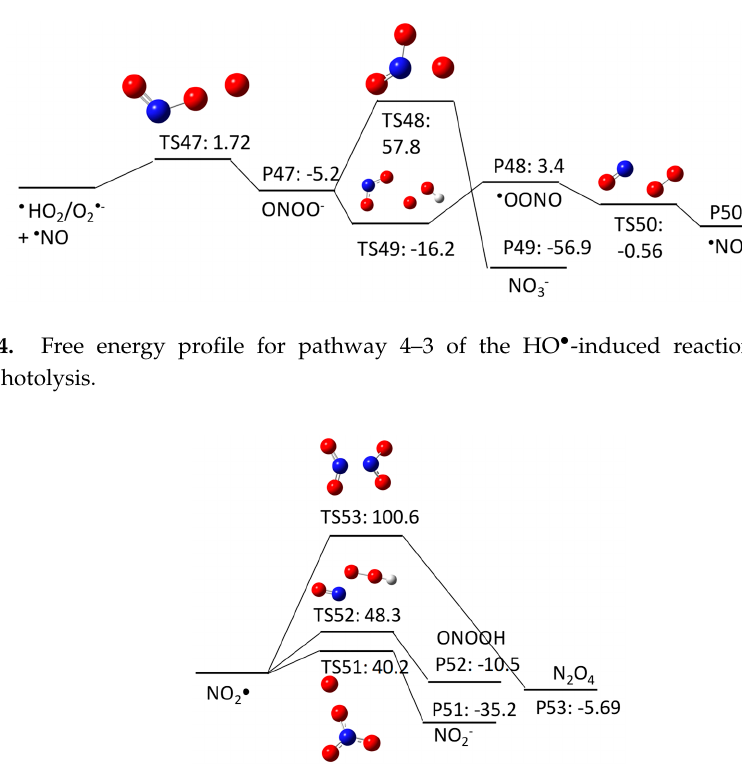
Figure 15. Free energy profile for the reaction of NO 2 • with HO • , O 2• − , and NO 2• .